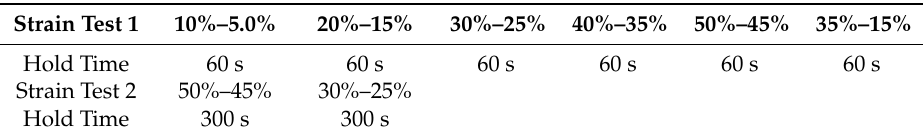
Table 1. Strain ranges applied to the test specimens.